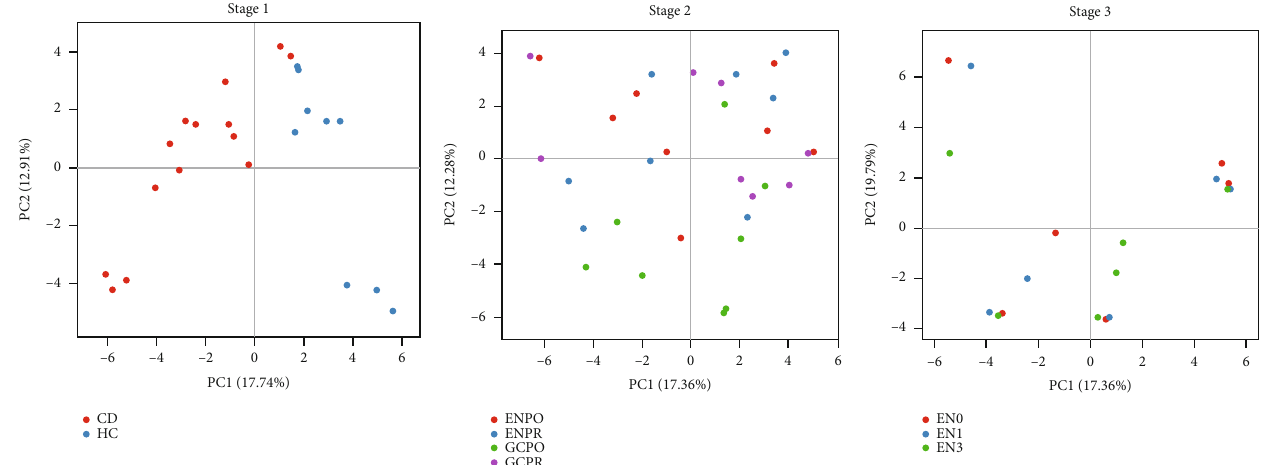
Figure 2: PCA in three stage. Abbreviations: HC: health control; CD: Crohn ’ s Disease; GCPR: before corticosteroids treatment; ENPR: before EEN treatment; GCPO: after corticosteroids treatment; ENPO: after EEN treatment; EN0: 0 month after EEN treatment; EN1: 1 month after EEN treatment; EN3: 3 months after EEN